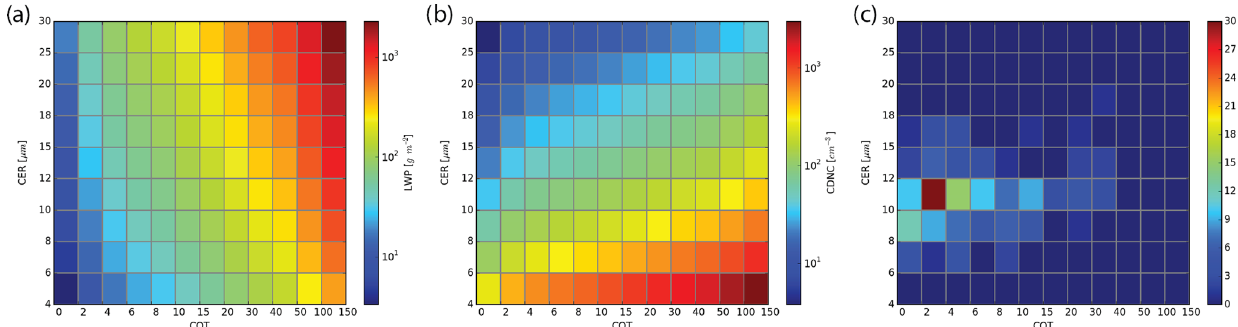
Figure 3. The (a) LWP and (b) CDNC as a function of COT and CER. (c) An example of the COT–CER joint histogram observed by Aqua MODIS on 9 January 2007 at 1 ◦ S and 1 ◦